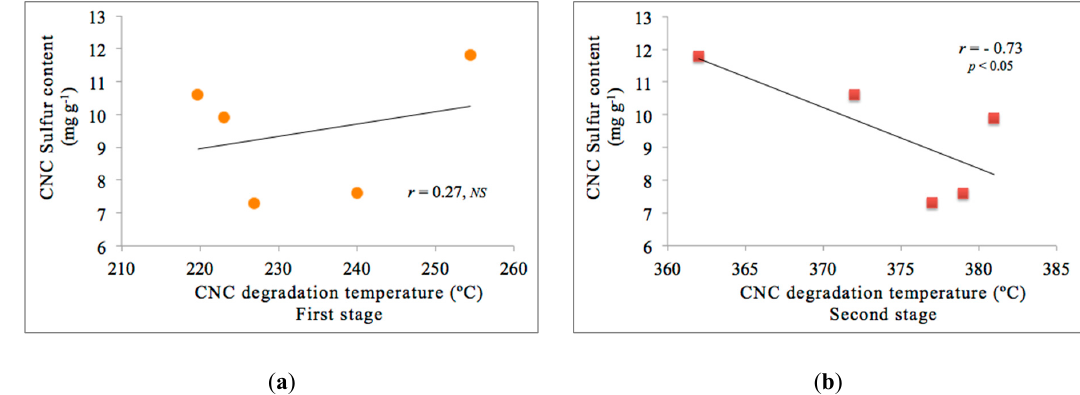
Figure 7. Regression lines and Pearson correlation between CNC sulfur content vs . CNC degradation temperature. ( a )FirststagedegradationofDTGand( b )SecondstagedegradationofDTG.Themaximum temperature. ( a ) First stage degradation of DTG and ( b ) Second stage degradation of DTG. The standard error for CNC sulfur content is 0.5 mg g − 1 and for CNC degradation temperature in the first maximum standard error for CNC sulfur content is 0.5 mg g -1 and for CNC degradation temperature stage is 2 ◦ C and the second stage is 1.5 ◦ in the first stage is 2 °C and the second stage is 1.5 °C.